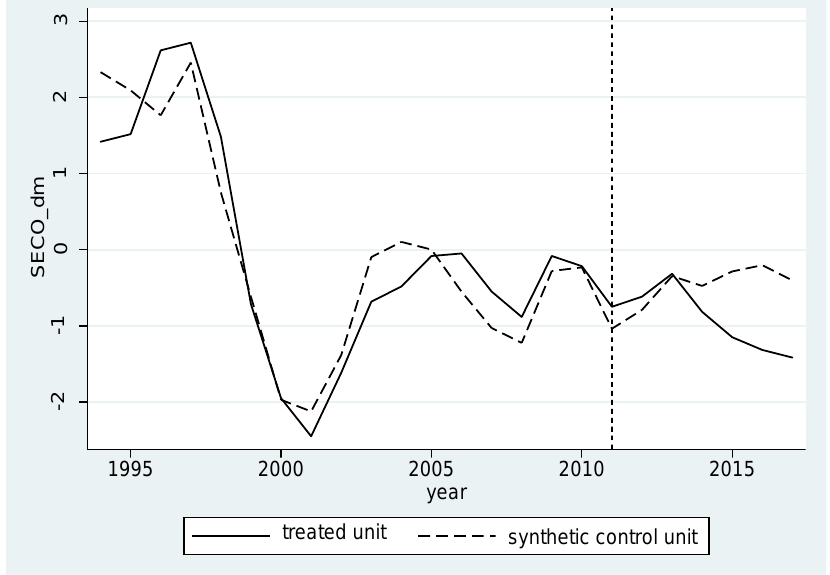
Figure 2. Demeaned SC and Ticino unemployment rate, including all pre-treatment variables as